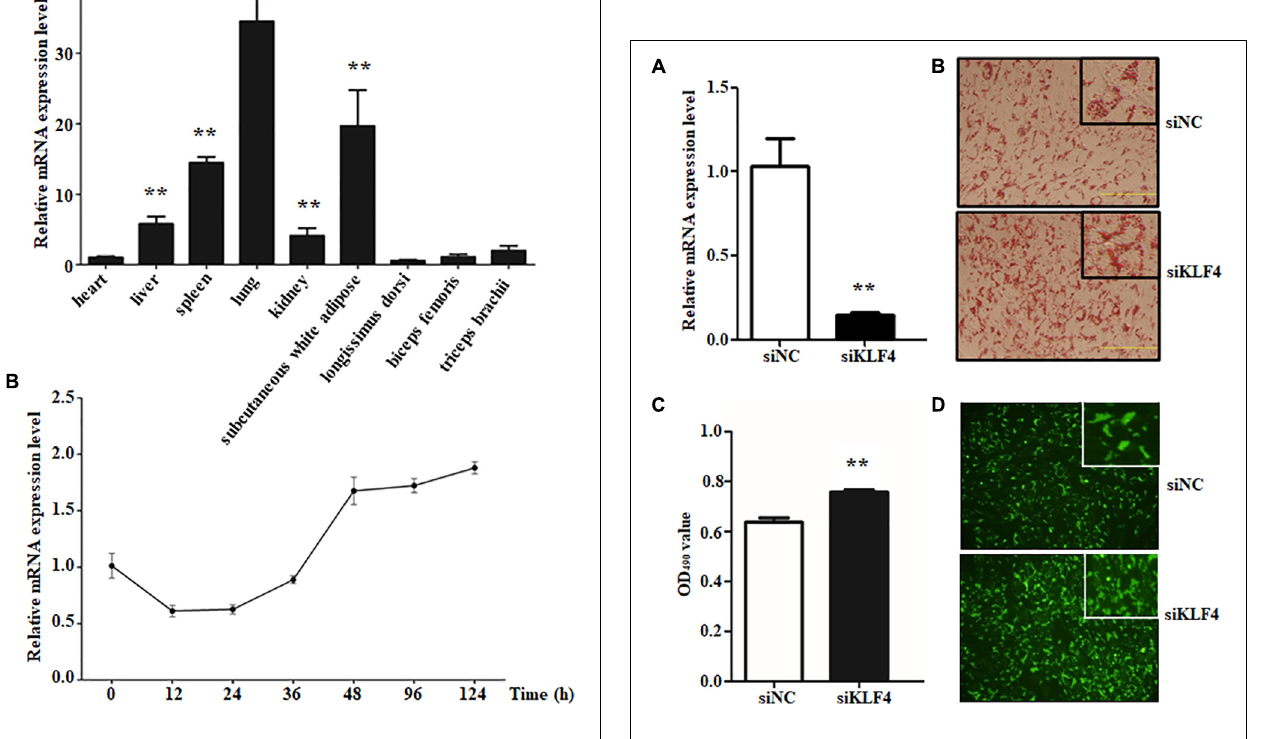
FIGURE 1 | The expression level of KLF4 in different tissues and during intramuscular preadipocyte differentiation. (A) The mRNA level of KLF4 in the heart, liver, spleen, lung, kidney, subcutaneous white adipose tissue, longissimus dorsi, biceps femoris, and triceps brachii of goats ( n = 6). (B) The mRNA level of KLF4 at 0, 12, 24, 36, 48, 96, and 124 h after intramuscular preadipocytes adipogenic differentiation. The data are presented as the mean values ± SD. Each experiment was performed at least in triplicate, producing consistent results. * p < 0.05, ** p < 0.01.